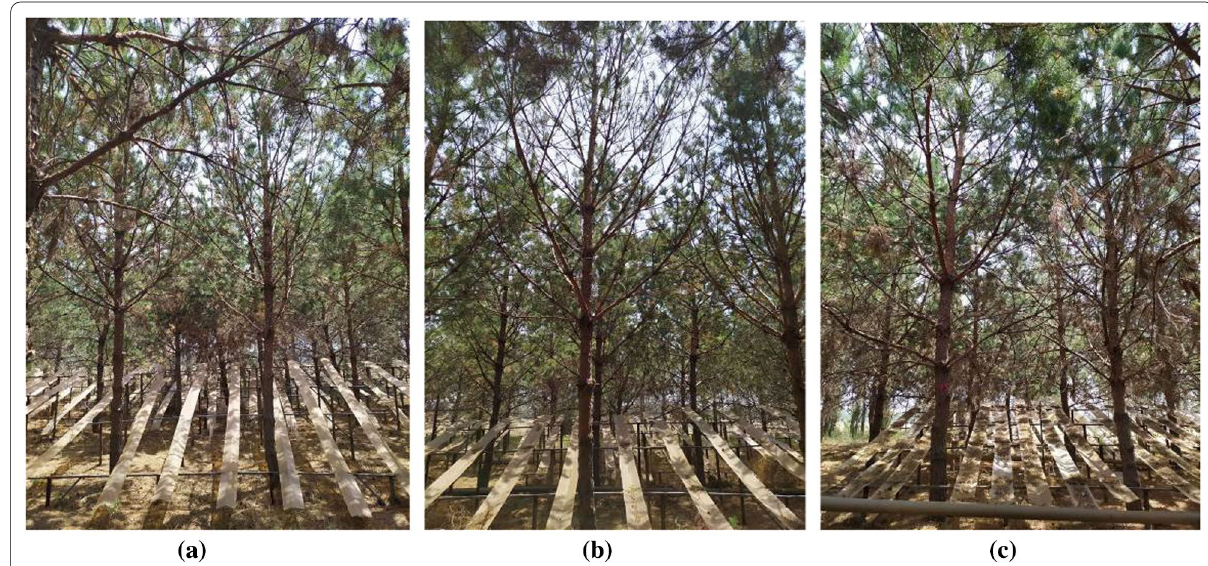
Fig. 1 Three throughfall reduction treatments in a Mongolian pine plantation: control ( a ), no throughfall exclusion; 30% drought ( b ), 30% of throughfall exclusion area; 50% drought ( c ), 50% of throughfall exclusion